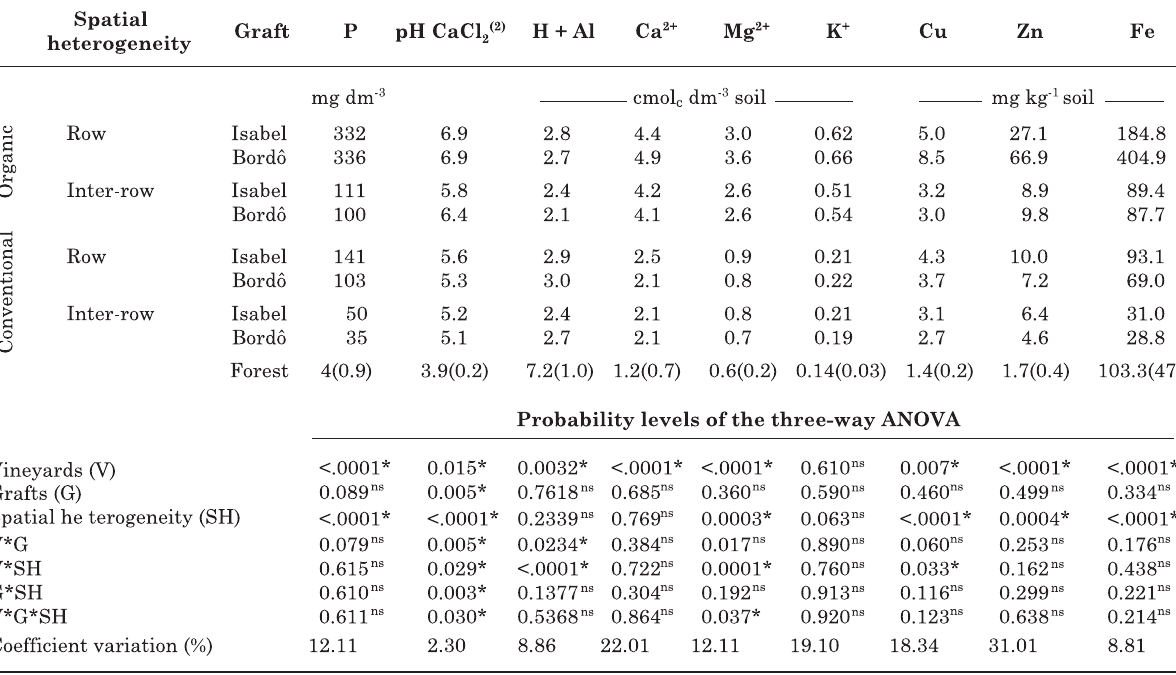
Table 2. Selected chemical characteristics of soil in vineyards after six years of organic and conventional management and from an adjacent forest